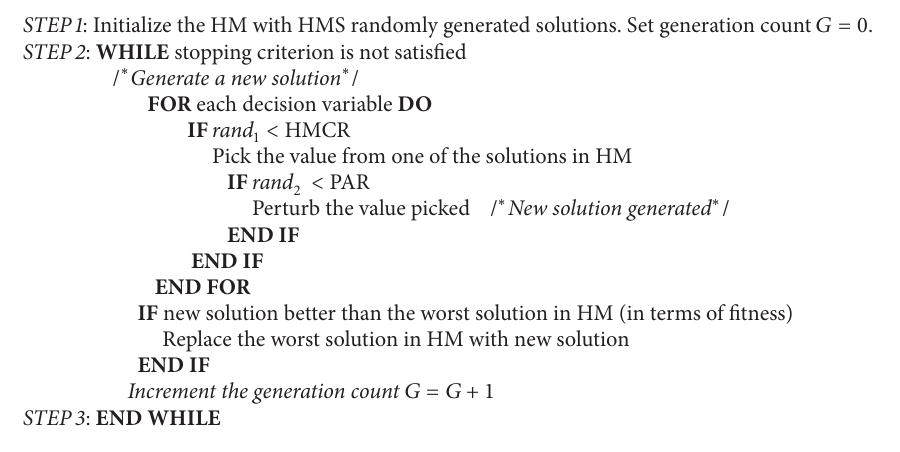
Algorithm 2: Standard harmony search